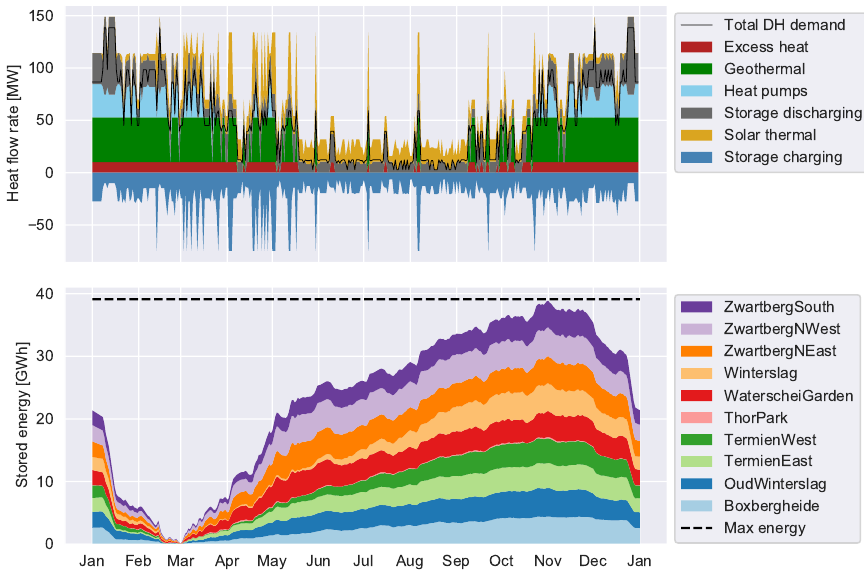
Figure 9. Full year time series for minimum PEIS